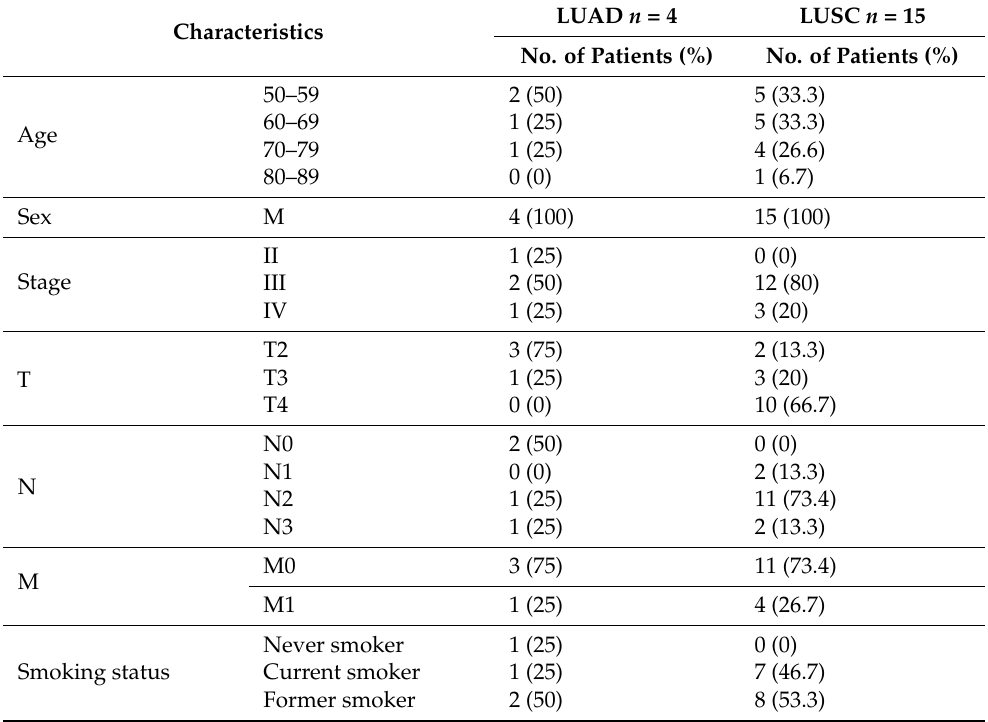
Table 4. Demographic and histopathological diagnosis of the 19 NSCLC patients used for plasma qRT-PCR validation of miR-34c-5p and miR-183-3p, and ELISA determination for EGFR, IGF-IR, and TGF β 1 from